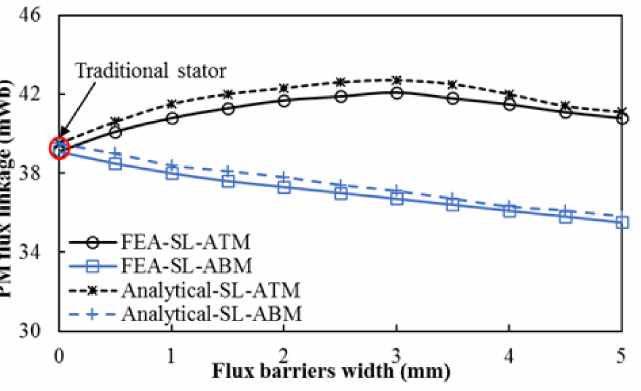
Figure 5. Variation of the PM flux linkage of different machines with the width of the flux